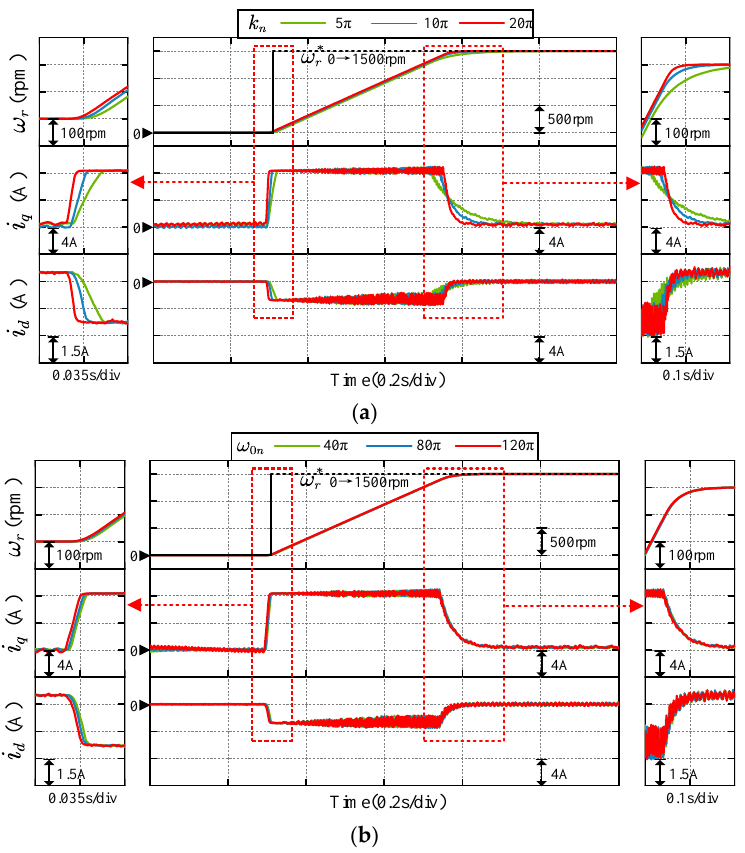
Figure 13. Experimental results of the speed response with step speed reference from 0 rpm to 1500 rpm. ( a ) Under different k n , where ω 0 n = 80 π , k n = [ 5 π ,10 π ,20 π ] ; ( b ) under different ω 0 n , where k n = 10 π , ω 0 n = [ 40 π ,80 π ,120 π ] .